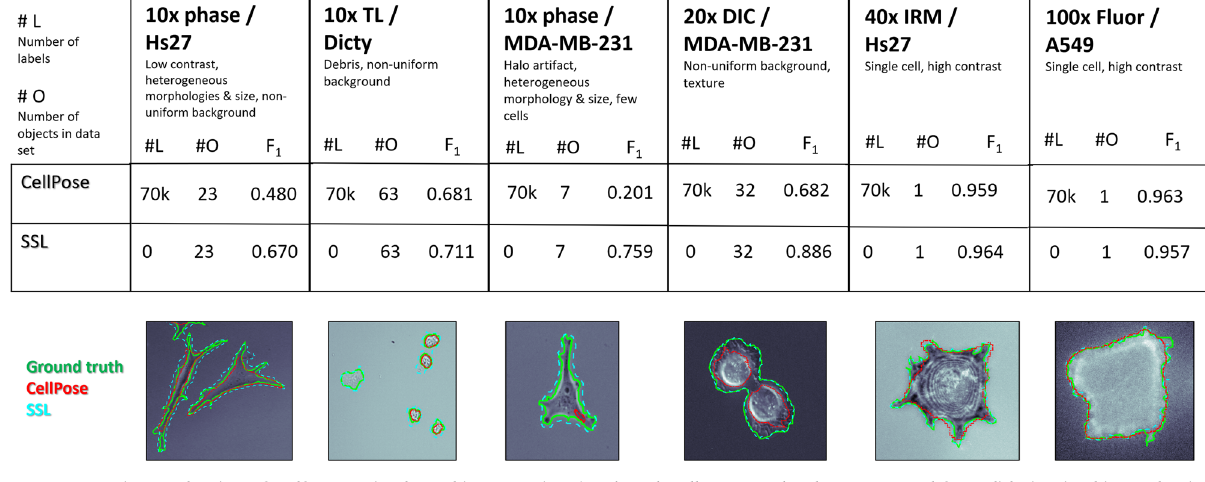
Fig. 4 Segmentation evaluation of Self-Supervised Machine Learning (SSL) and CellPose on the data sets used for validation in this study via F 1 - scores. The top row includes the name of the data set annotated by magni fi cation, optical modality, cell type and brief description of the imagery characteristics. #L stands for the number of annotated labels used for model training, and #O stands for the number of objects to be segmented by the model within a given data set. *CellPose has a single parameter, a size fi lter, that can be automatically estimated, however, for some of the data sets the best segmentation was found by manually tuning this size fi lter. The fi gures below show the ground truth (green-solid lines), SSL (cyan-large dashes), and CellPose (red-small dashes) outlines overlaid on the fi nal image of the data